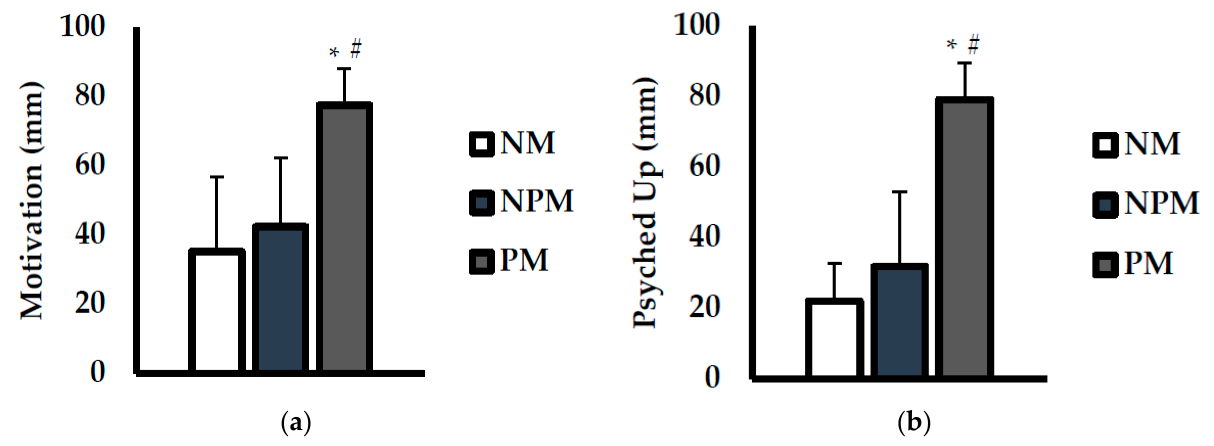
Figure 3. Comparisons of ( a ) motivation and ( b ) feelings of being psyched up during testing between no music (NM; white), non-preferred music (NPM; blue), and preferred music (PM; grey) conditions. Data are presented as mean ± SD. * indicates significantly different than NPM ( p < 0.05). # indicates significantly different than NM ( p < 0.05).